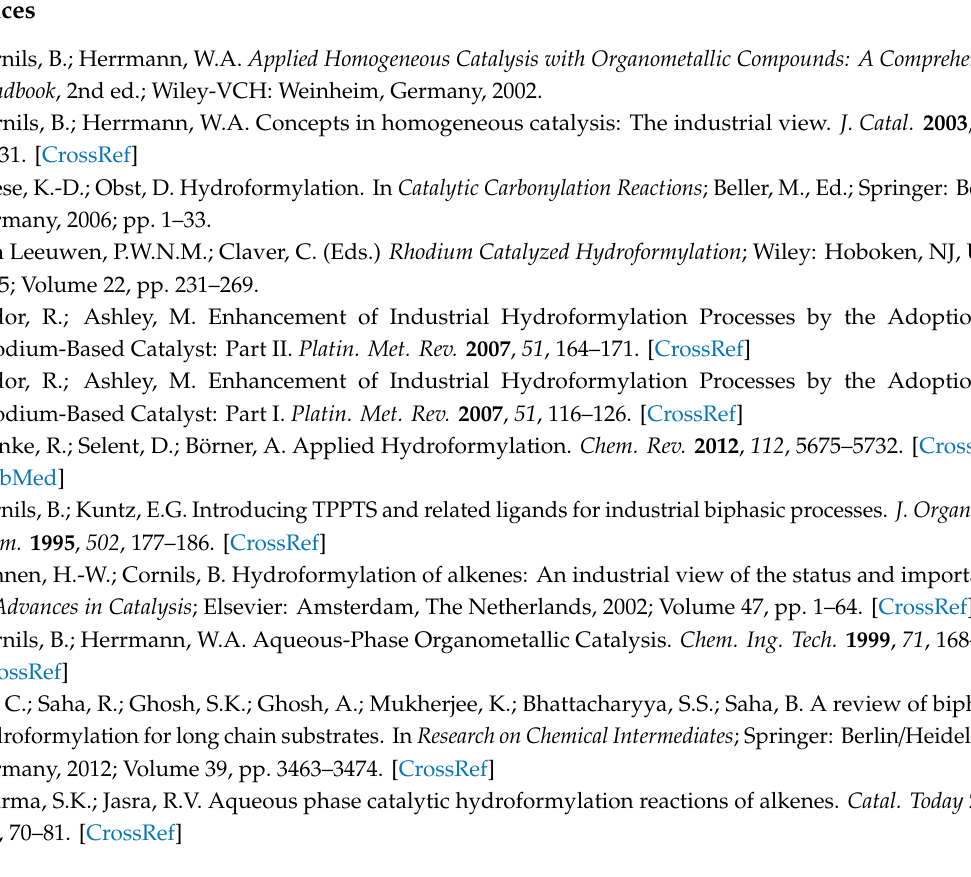
Figure S1: 31 P{ 1 H} NMR of compound 1 in CDCl 3 , Figure S2: 1 H{ 31 P} COSY NMR of compound 1 in CDCl 3 , Figure S3: 1 H- 13 C{ 31 P} HMQC of compound 1 in CDCl 3 , Figure S4: Comparison of 13 C{ 1 H} (below) and 13 C{ 1 H, 31 P} (above) NMR spectra of 1 in CDCl 3 for selected expanded regions of the spectrum, Figure S5: 1 H- 13 C HMBC of compound 1 in CDCl 3 , Figure S6: 1 H NMR of compound 2 in CDCl 3 , Figure S7: 31 P{ 1 H} NMR of compound 2 in CDCl 3 , Figure S8: 1 H NMR spectrum of nixantphos@CCM in THF- d 8 , Figure S9: 1 H NMR spectrum